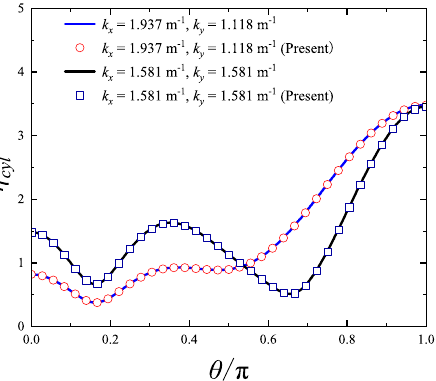
Figure 2. The non-dimensional wave run-up around a solid cylinder obtained from the present model was compared with the results from Jian et al. [29] (plotted as lines) with h = 5 m, β = π /6, b = 1 m, γ = 0, and U 0 = 0.2